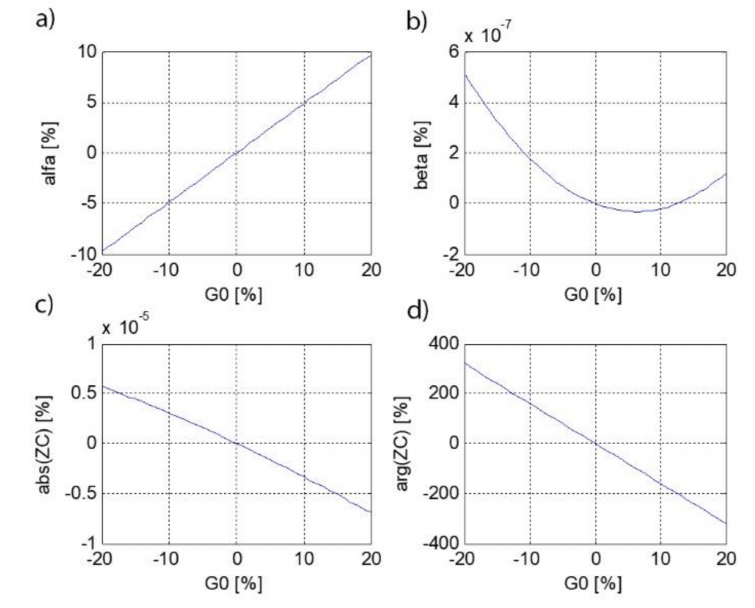
Figure 13. Changes of wave parameters depending on G 0 at f = 1 MHz; ( a ) damping factor α , ( b ) phase factor β , ( c ) wave impedance modulus, and ( d ) wave impedance argument. Changes to the U 2 voltage modulus occur when the R 0 parameter is changed linearly, and vary from 0.4% to − 0.4%, depending on the frequency. The higher the frequency, the smaller the change (Figures 14a, 15a and 16a). The U 2 argument increases almost linearly from − 2% to 2%, depending on the frequency (Figures 14b, 15b and 16b). The I 2 Modulus changes linearly from 0.4% to − 0.4% for lower frequencies, and 0.04% to − 0.04% for higher tested frequencies (Figures 14c, 15c and 16c). The I 2 argument rises linearly from − 2.1% to 2.1% for 500 kHz, and − 0.13% to 0.13% for 1 MHz (Figures 14d, 15d and 16d).